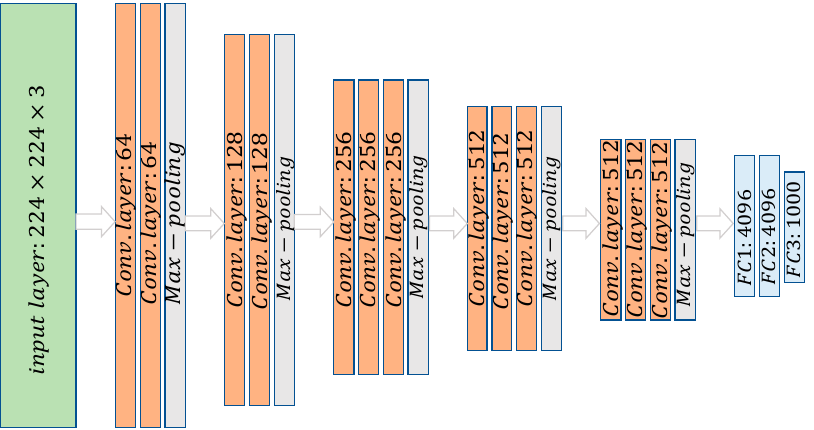
Figure 3. Architectural illustration of VGG16 model.